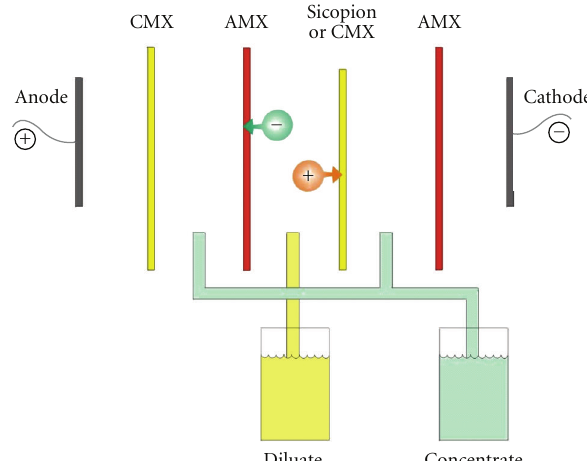
Figure 1: Configuration of the electrodialysis (ED) cell used for demineralization of solutions. CMX: CMX-SB cation-exchange membrane, AMX: AMX-SB anion-exchange membrane, (+) dem- ineralizing cations, ( − ) demineralizing anions. The electrode- rinsing solution circuit is not shown. Adapted from